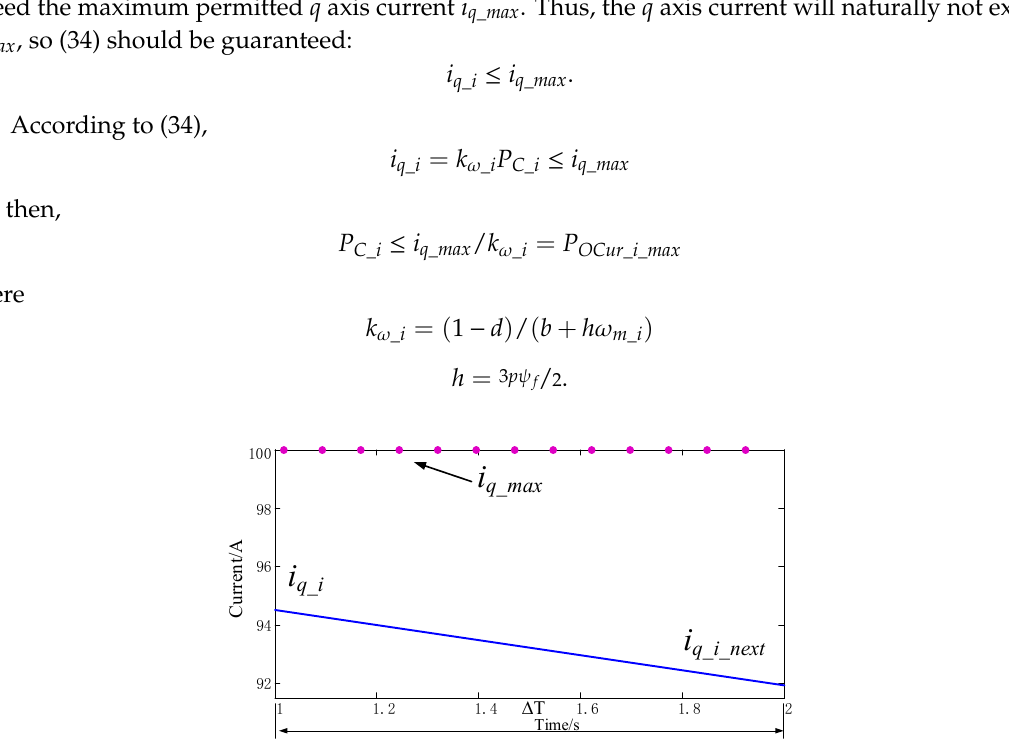
Figure 8. Prevention of overcurrent during charging.